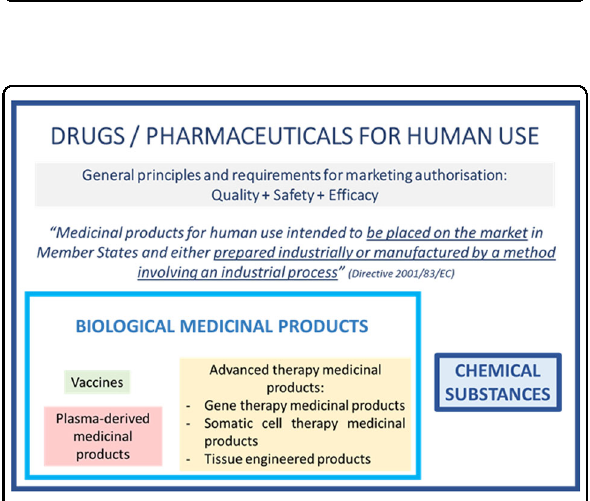
Fig. 3 EU legislative framework relative to biological medicinal